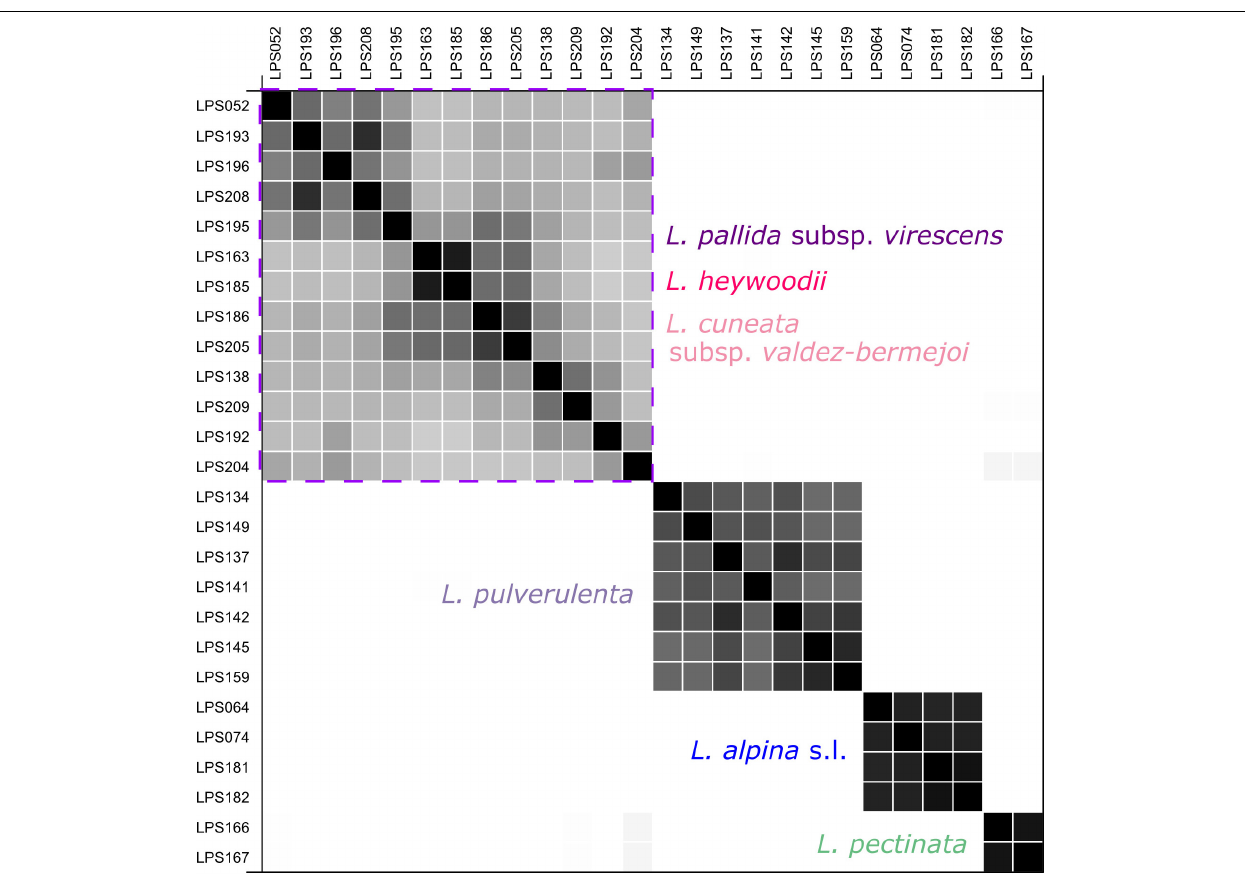
FIGURE 6 | Similarity matrix produced by the coalescent-based species-delimitation analyses (S TACEY ) for the diploid members of Leucanthemopsis . Posterior probabilities for pairs of individuals belonging to the same cluster (species) are shown in black (1.0) and white (0.0). The purple square encloses the cluster including samples of L. cuneata subsp. valdes-bermejoi, L. heywoodii, and L. pallida subsp. virescens . The colors correspond to those of Figure 1